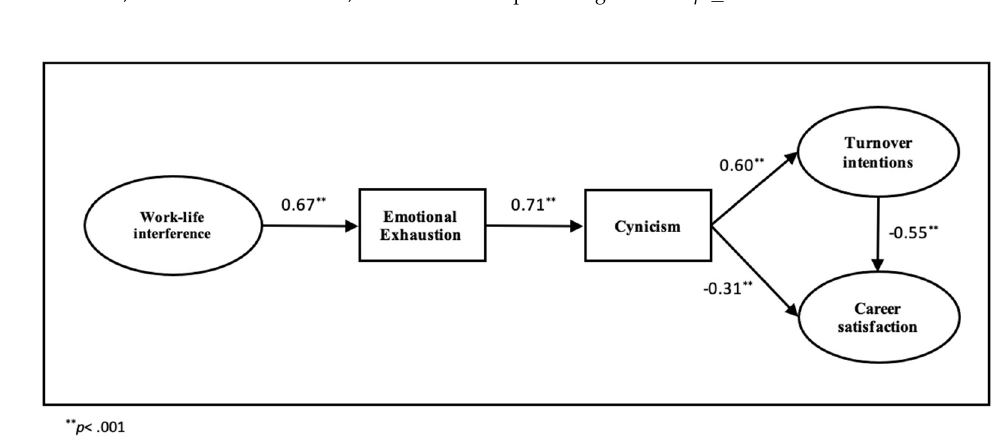
Figure 2. Final study model. Standardized coefficients.